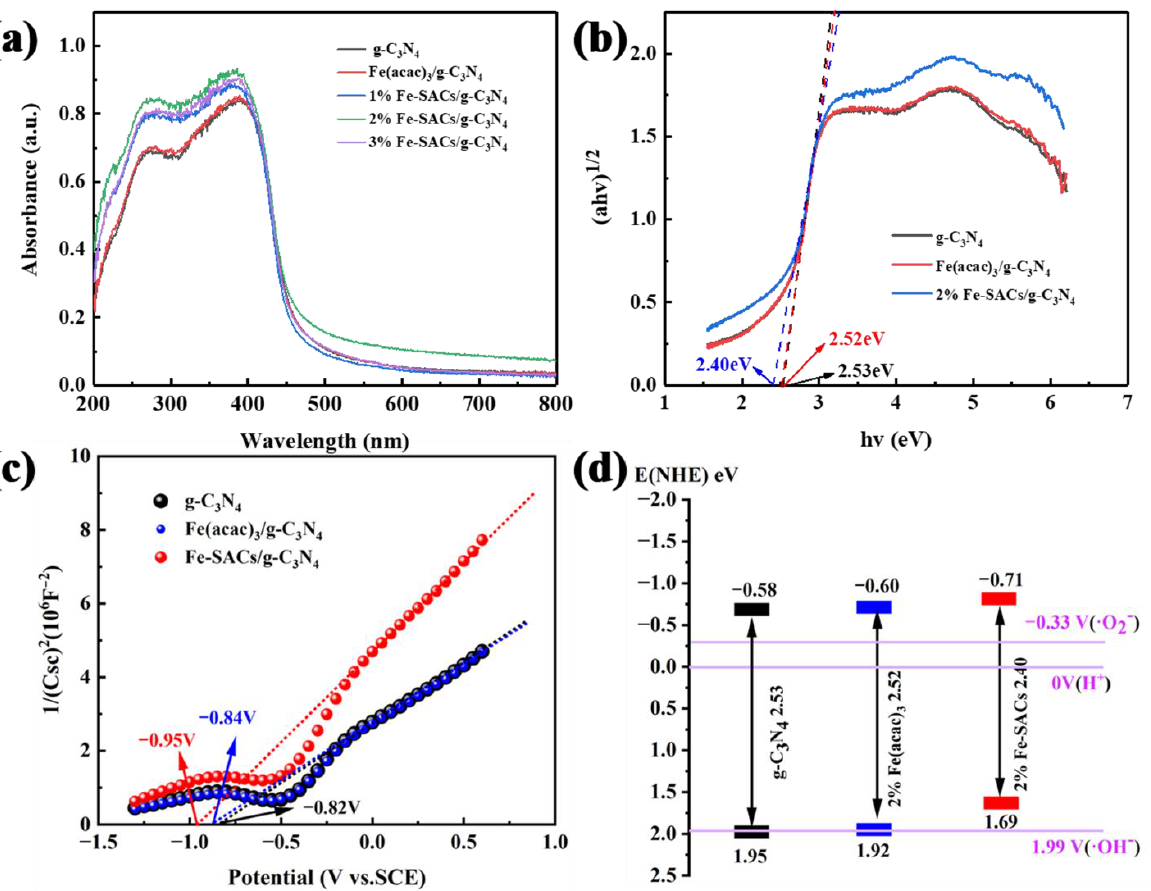
Figure 6. UVvis absorption spectrum ( a ); Tauc diagram of photocatalysts ( b ); Mott–Schottky curves ( c ); energy band diagram ( d ).